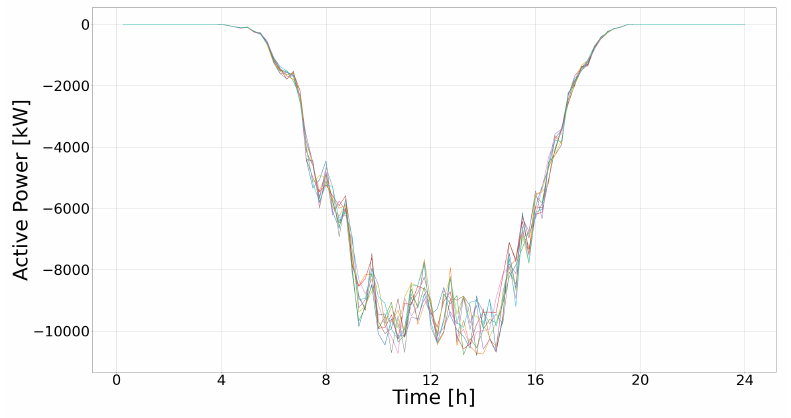
Figure 5. Examples of PV generation time series used for the construction of the training scenarios for the RL agent.